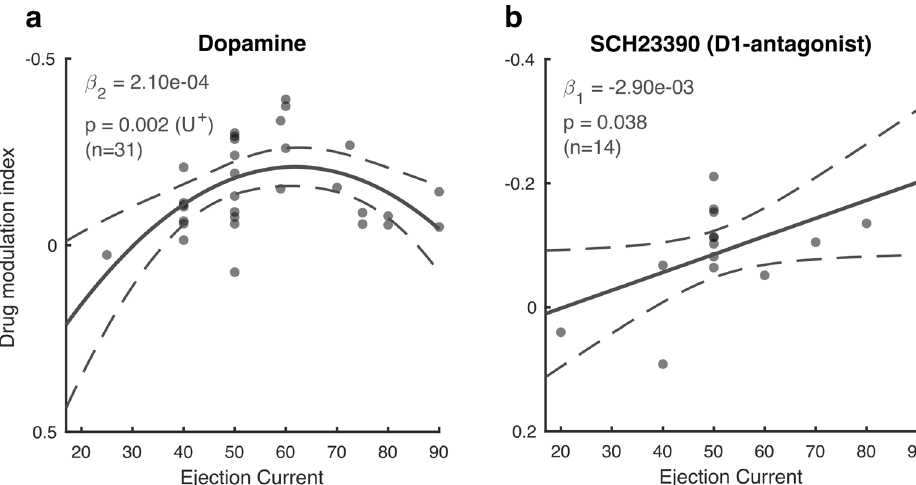
Figure 3. Dose–response curves. ( a, b ) Drug modulation index plotted against ejection current for the non-specific agonist dopamine ( a ) and the D1R antagonist SCH23390 ( b ). Note the reversed y-axis. Solid and dotted lines represent significant model fits (applied to all cells simultaneously) and their 95% confidence intervals, respectively. A monotonic relationship is shown if a first-order fit was better than a constant fit, and a non-monotonic relationship is shown if a second-order fit was better than a linear fit. U + indicates